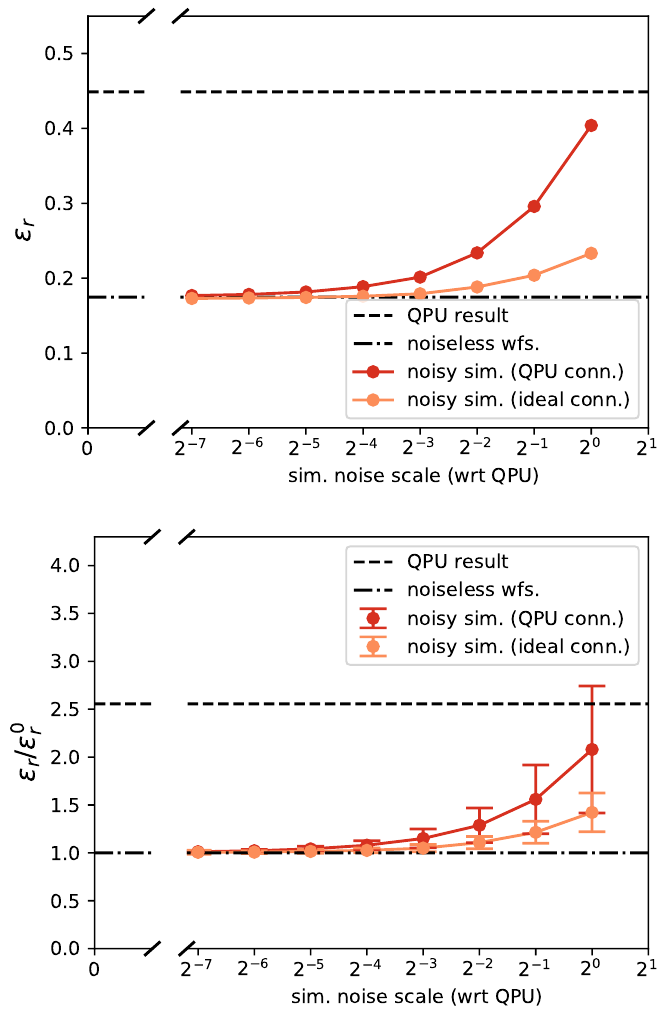
Figure 6: (TOP) Comparison of relative error (cid:34) with respect to the scaled noise r model simulations for a typical 5 qubit problem instance (log scale). Noiseless wave- form simulation as well as QPU results are also plotted for reference. (BOTTOM) /(cid:34) 0 Relative error factor (cid:34) with respect to the scaled noise model simulations (log r r scale). Here, (cid:34) 0 refers to the relative error observed in the case of the noiseless wave- r /(cid:34) 0 function simulator and (cid:34) measures (cid:34) as a factor of (cid:34) 0 . Values plotted on the y r r r r axis are medians (error bars are in Median Absolution Deviations) calculated from the values of the 30 selected 5 qubit problems. The QPU result in the bottom plot has a MAD of 1.04. Both plots are made with results from a QAOA depth of p = 1, for device-limited coupling map restrictions (QPU conn.) and all-to-all connectivity (ideal